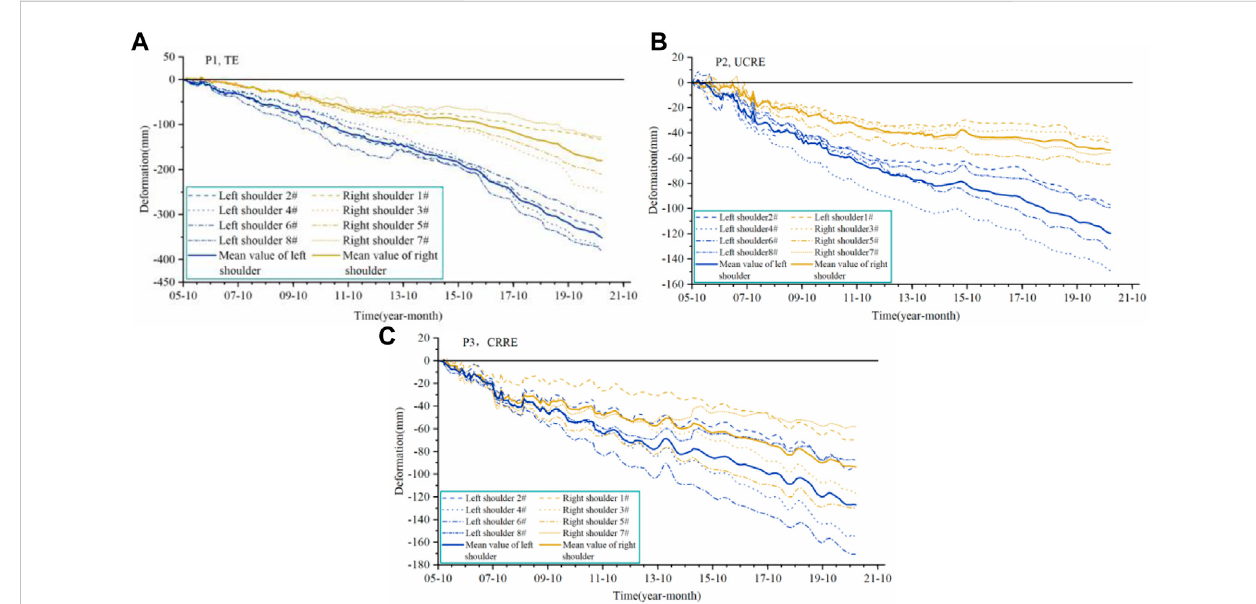
Annual deformation of the left and right embankment shoulders in the three monitoring sections. (A) P1, TE, (B) P2, UCRE, and (C) P3,